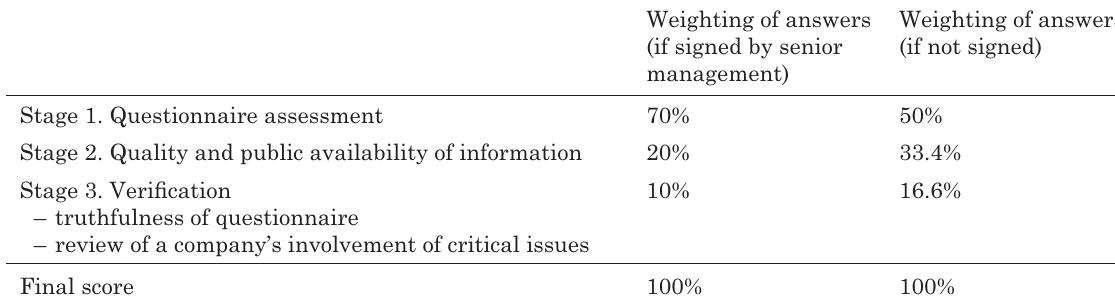
Table 4. Stages of sustainability